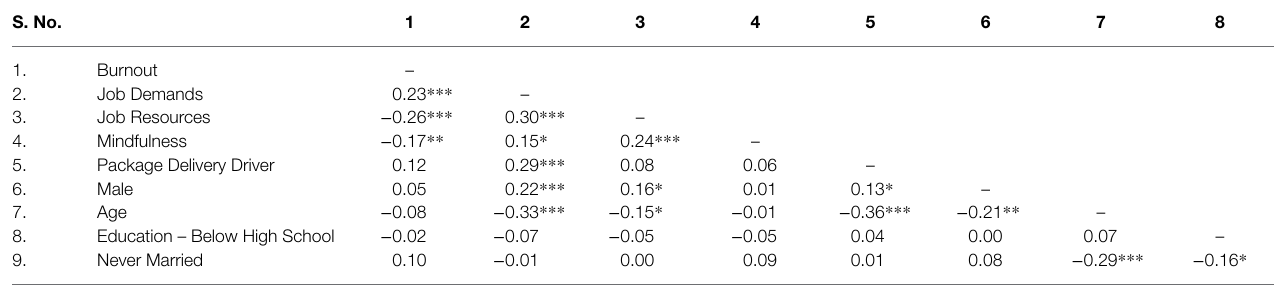
TABLE 2 | Correlation analysis of key